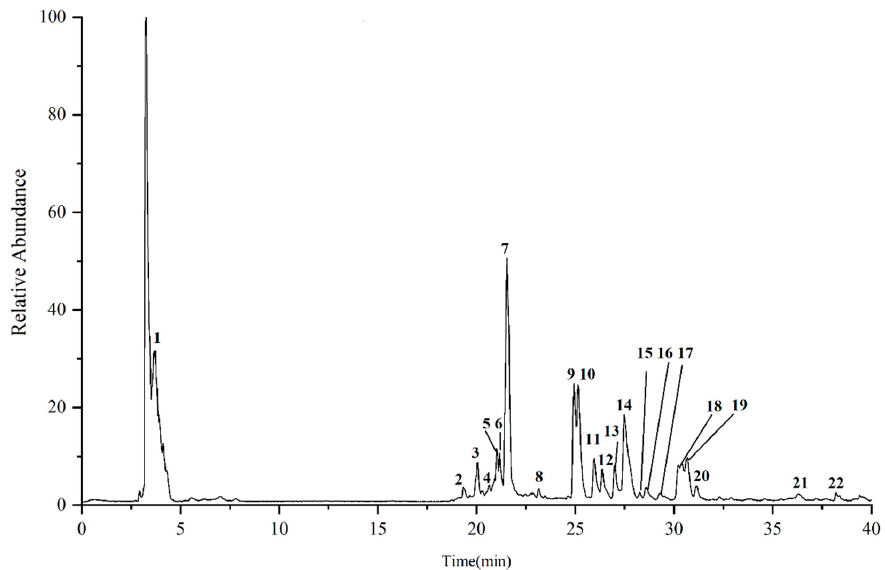
Figure 2. Total ion flow diagram (negative ion mode) of phloem in ginseng.